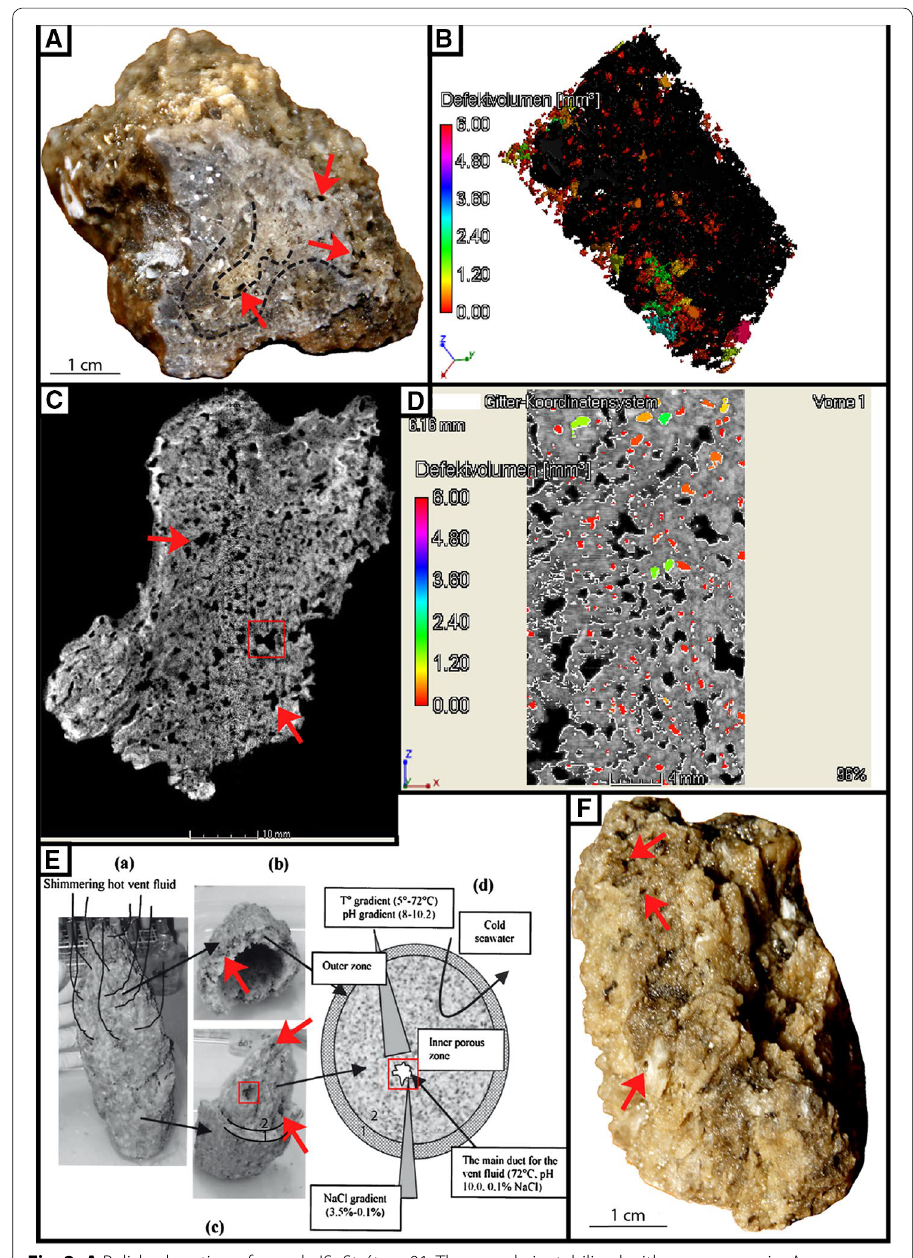
Fig. 2 A Polished section of sample IS_Strýtan_01. The sample is stabilized with an epoxy resin. An enor- mous amount of pore space is obvious ( red arrows ). An internal stratification reveals depositional events ( dashed lines ). B Porosity analysis calculated from the XCT investigation. The color bar scales the pore volume. Apparently, few small pores have developed. Generally, large pores up to 6 mm 3 prevail, showing a relatively homogenous spatial distribution. C XCT scan of the sample IS_Strýtan_01. The enormous amount of pore space in the sample is well visible ( white —smectite, black —air/pore space). The red arrows mark the major water pathways. The red square shows one main duct as shown in E . D 2D projection of the porosity analysis. A homogenous distribution of the pores is well visible. The indicated great abundance of large pores hints on the large available pore space being involved in fluid migration. The material is highly permeable. E Sample investigated by Marteinsson et al. (2001). This sketch outlines clearly the layered construction of the chimney and shows the small tubes emitting the hydrothermal fluid ( red arrows ; modified after Marteinsson et al. 2001). F Sample IS_Strýtan_01 macroscopically. Red arrows mark the major dewatering tubes. Sample is in native